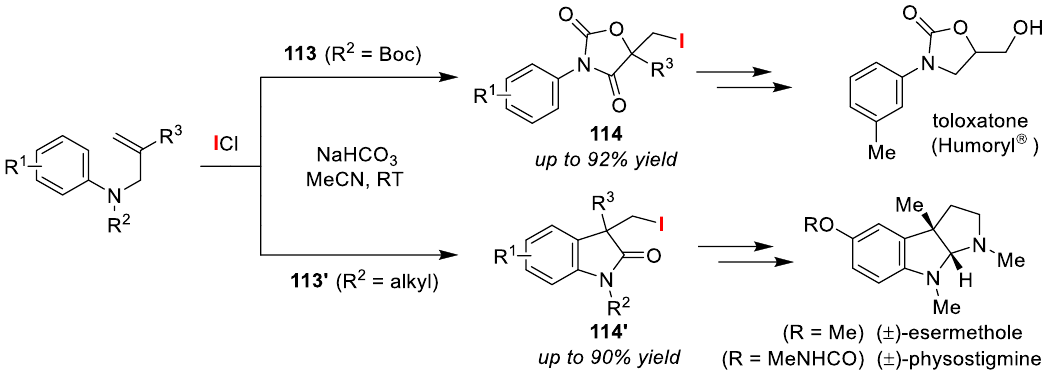
Figure 53. Selective synthesis of oxazolidine-2,4-diones 114 and oxindoles 11 4′ via the protection group dependent selective iodo-cyclizations of N -protected N -aryl-acrylamides 113 and 11 3′ .